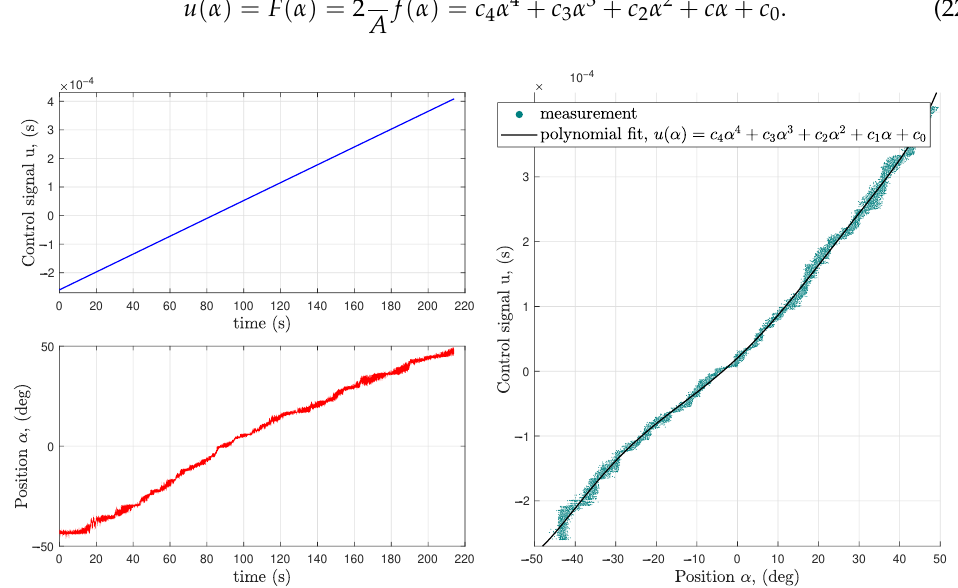
Figure 5. Results of the static measurement and the fitted curve for the static characteristic. After the experimental determination of the static behavior, dynamic parameter values for Θ and d are fine-tuned to match with the experimental step response results (Figure 6).